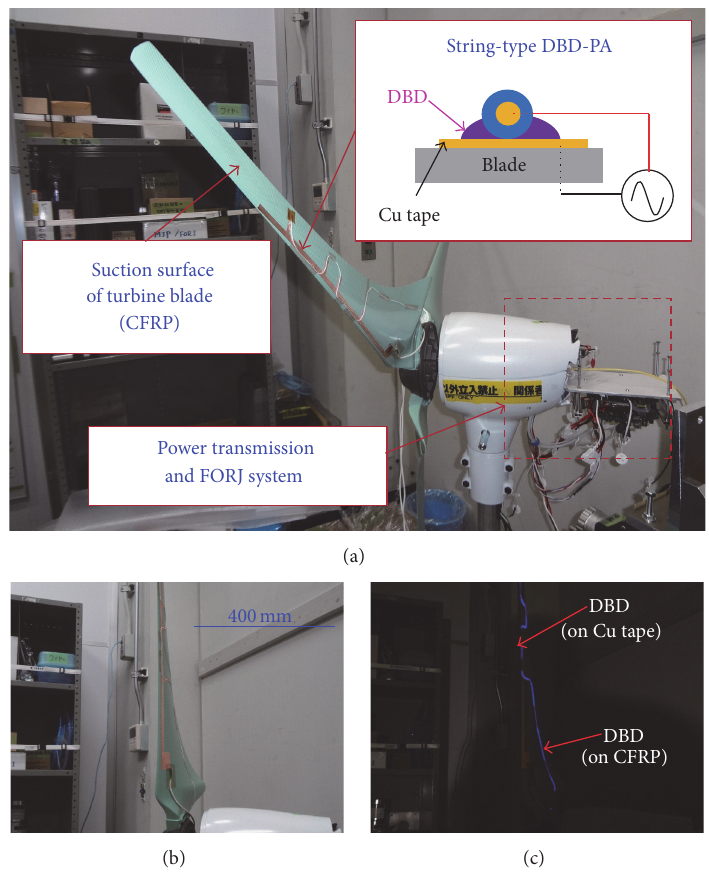
Figure 19: Pictures of feedback control system constructed in a 1kW-class wind turbine. (a) String-type DBD plasma actuator attached to the suctions surface of a turbine blade made of CFRP. Power transmission and FORJ system is connected to a rotary shaft near the tail of nacelle. (b) Pictures under illumination and (c) without ambient illumination. DBD plasma is formed around the copper wire coated with PTFE not only on copper tape, but also on CFRP